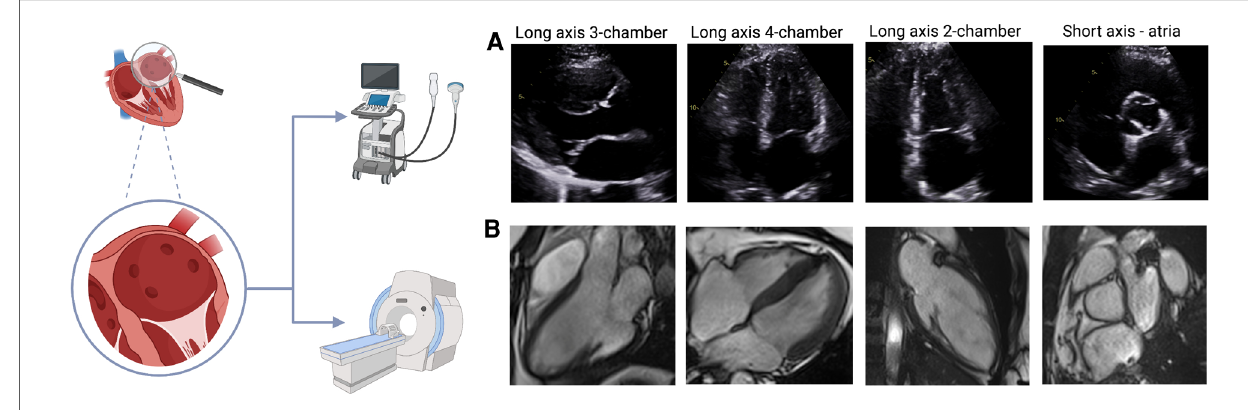
FIGURE 2 TTE and CMR views of the atria ( A ) TTE views of the atria: long axis 3-chamber, long axis 4-chamber, long axis 2-chamber, short axis. ( B ) CMR images of the atria in the same views. The images shown for each technique were acquired from our institute (St Vincent ’ s Hospital Sydney, Australia) with ethics